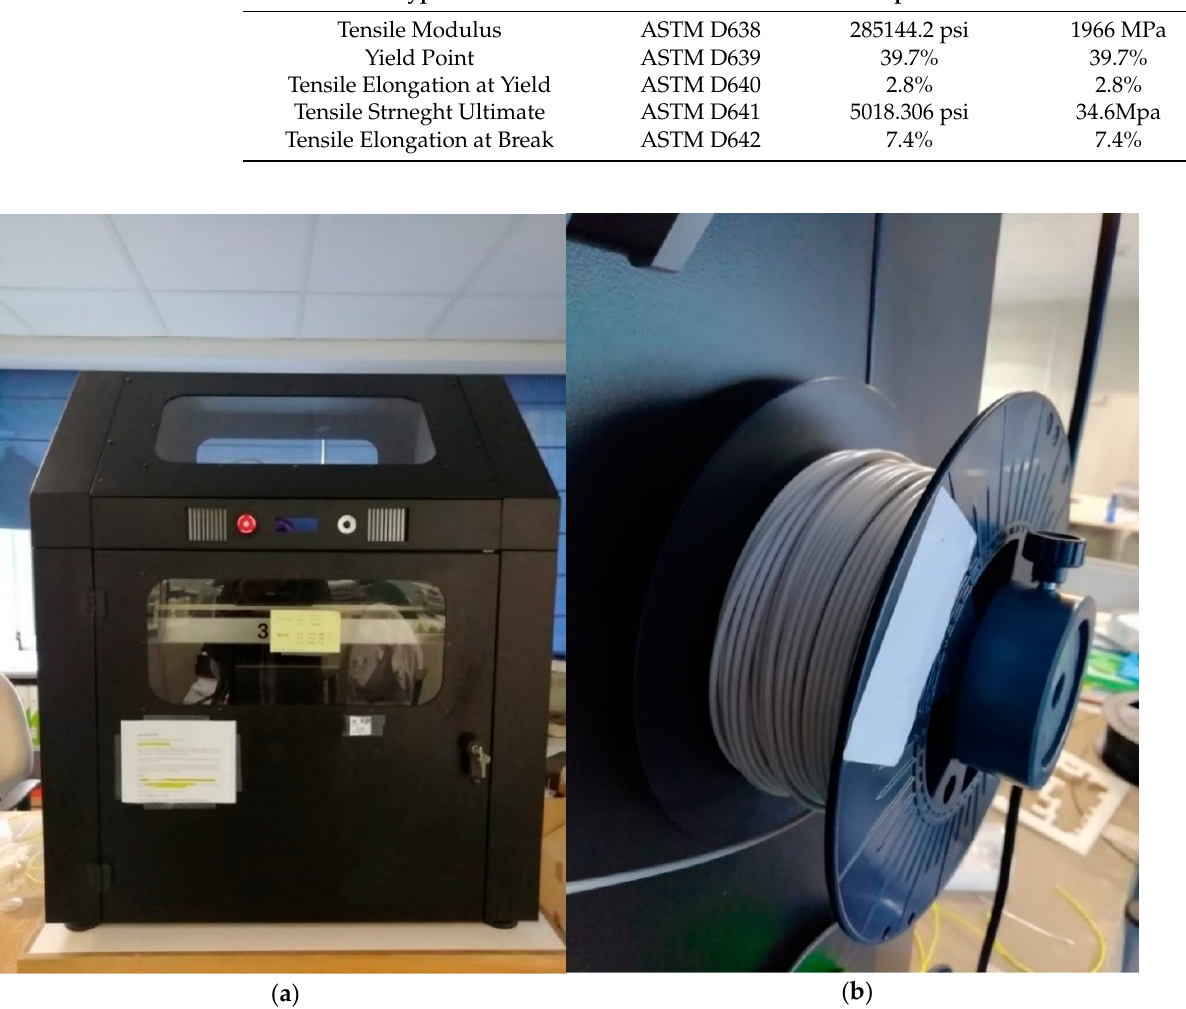
Table 2. PPS technical data sheet.